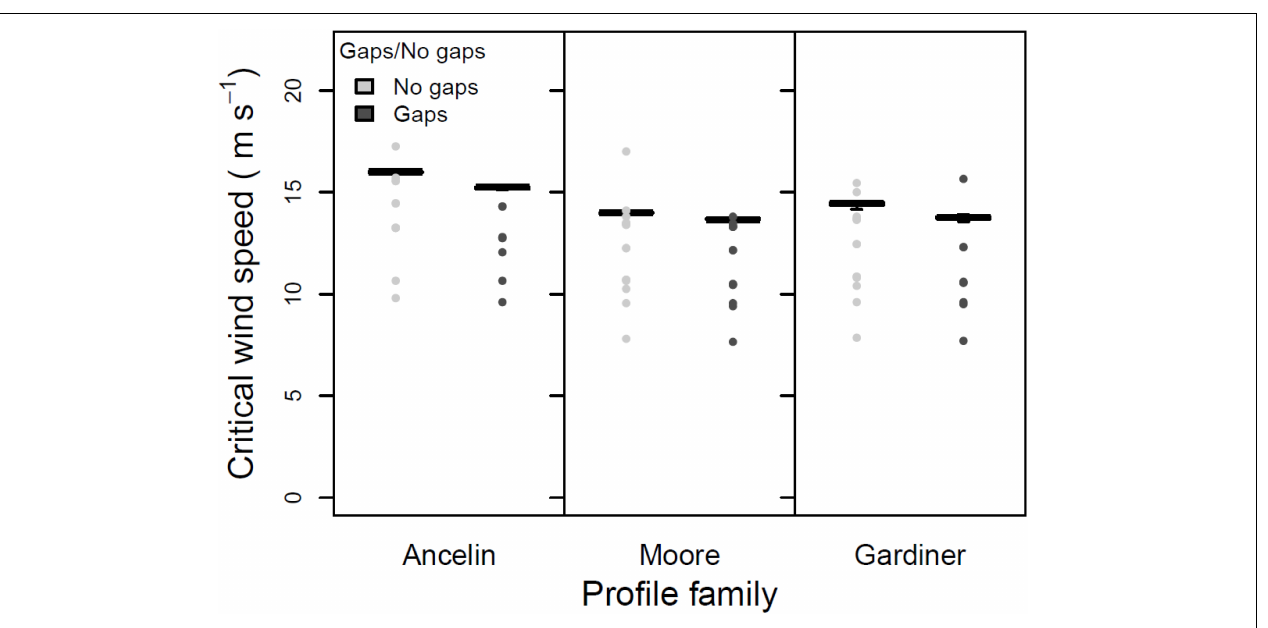
FIGURE 7 | Mean, 25 and 75% percentiles, 1.5 × interquartile range (whiskers), and outliers of critical wind speed (CWS) in m s − 1 , for three profile families, with and without gaps. Parameters constant across figure: stand orientation = A; alpha = 3.0 or LAI = 3.5; + indirect damage; + neighbor